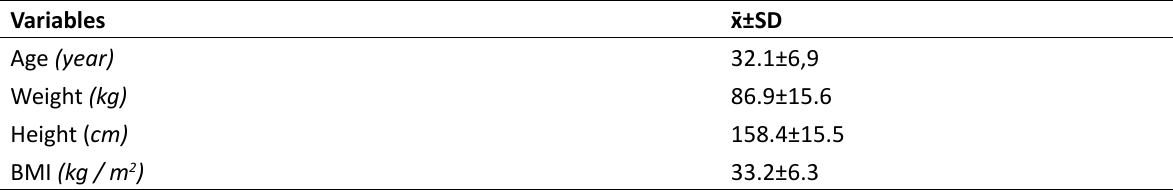
Table 2. Changes in Weight, BMI before and after 8-weeks Zumba exercise program Variables